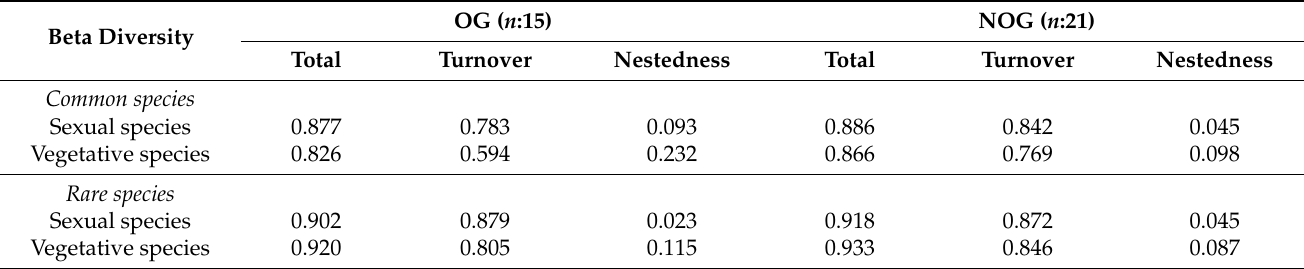
Table 3. Components of beta diversity in OG and NOG forests of the study area. The results are presented and are disaggregated according to the reproductive strategy and the level of national rarity of the species. Beta